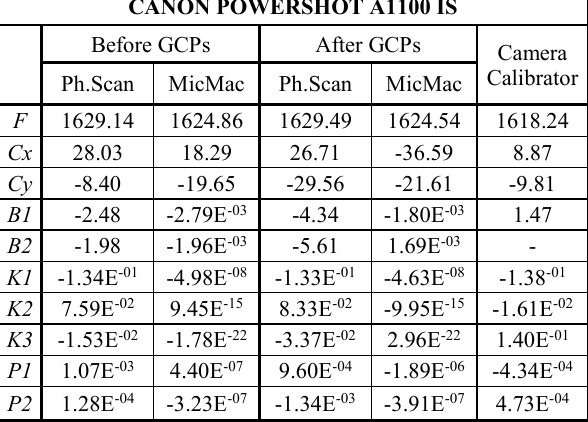
Table 10. Calibration parameters for the Canon compact camera evaluated with self-calibration before and after placing GCPs and parameters estimated by MatLab Single Camera Calibrator